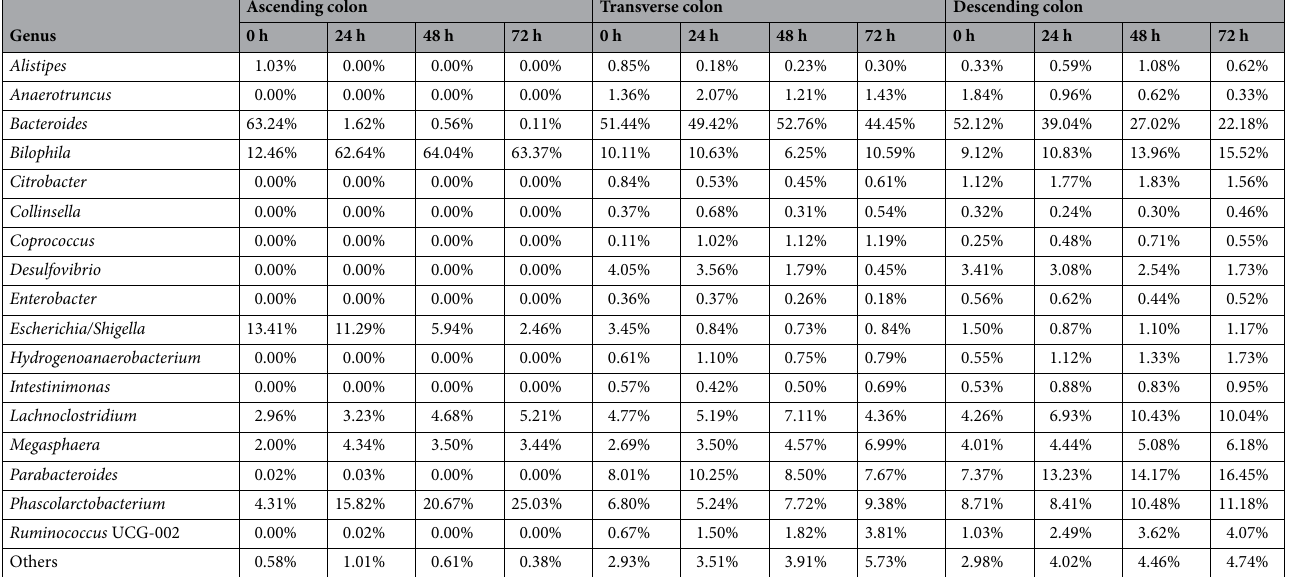
Table 2. Relative abundance changes at family level in each simgi colonic compartment at different times (hours) for volunteer 2. Taxa with a relative abundance > 0.5% are